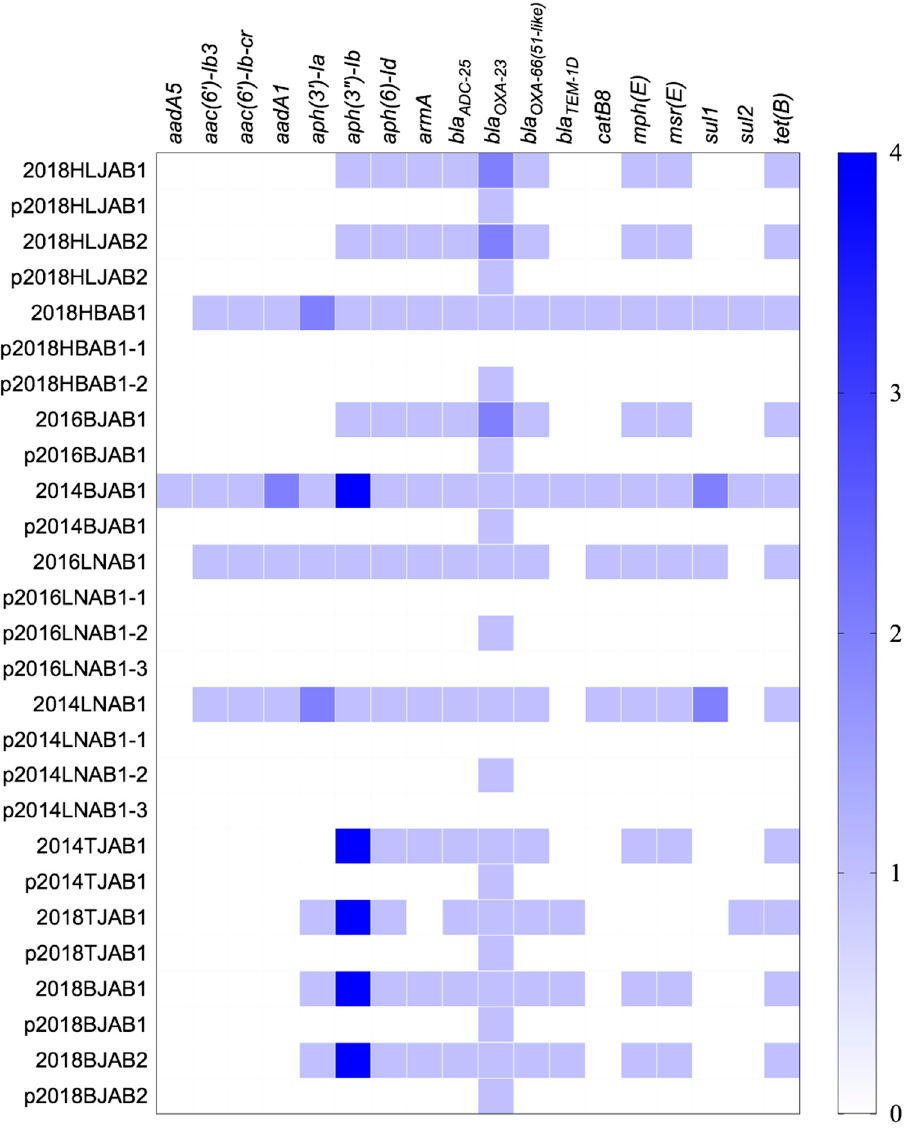
Figure 2. Distribution of antibiotic resistance genes in the chromosomes and plasmids of the 11 CO isolates. The color shade showed the copy numbers of genes.